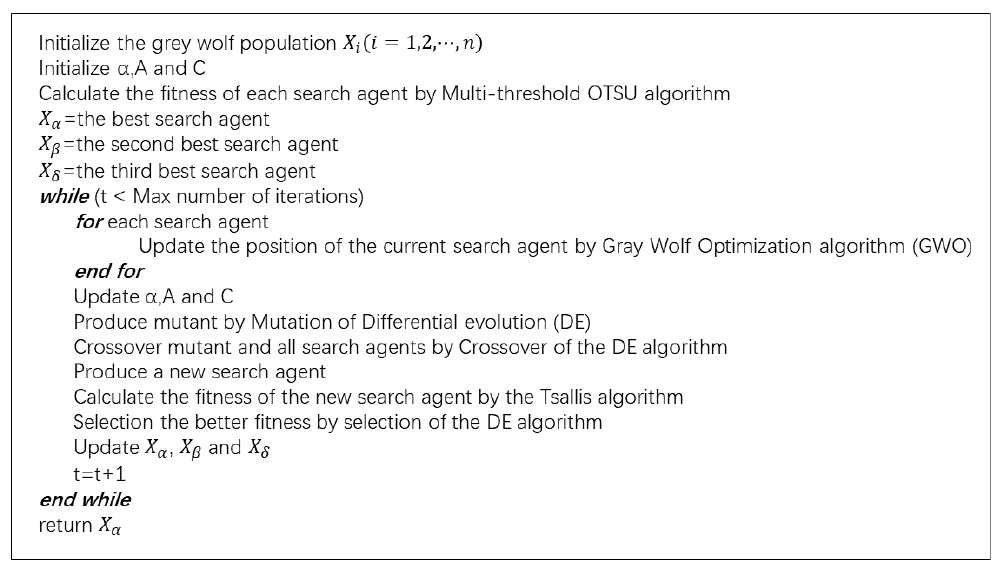
Figure 2. The pseudo-code of DE-OTSU-GWO algorithm.